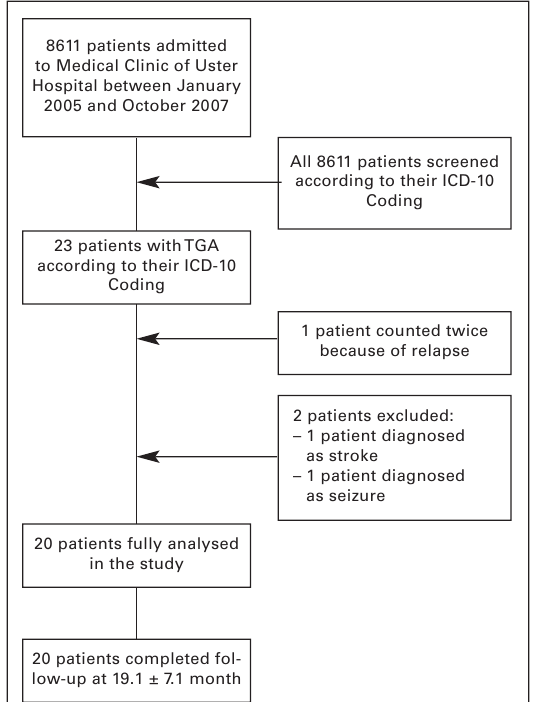
Figure 1 Flowchart of inclu- sion and